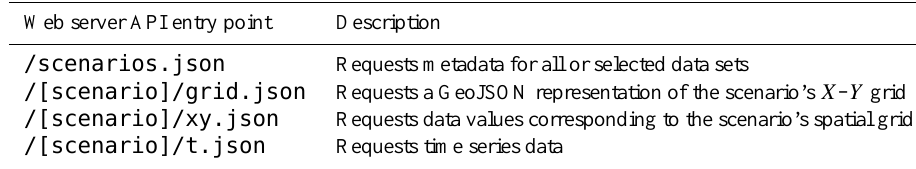
Table 2. Entry points for the Carbon Data Explorer web server API.